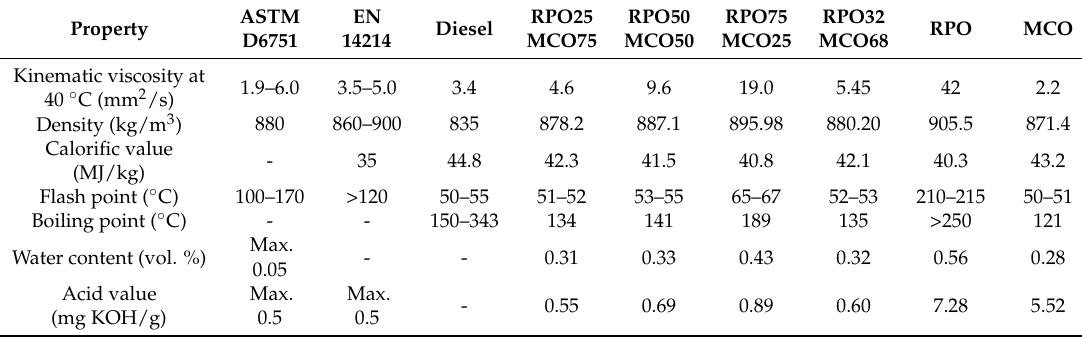
Table 3. Physicochemical properties of neat and blends of refined palm oil-Melaleuca Cajuputi oil